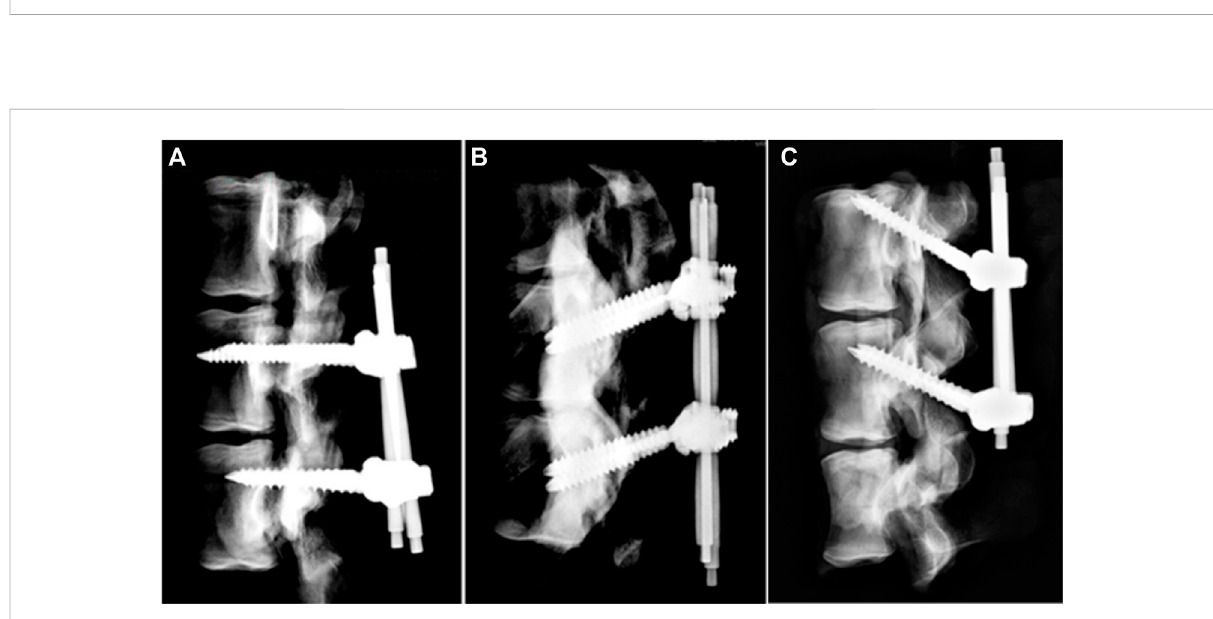
X-ray images of the FSU constructs after assembly of the screw and rod. (A) TT, (B) MT, and (C) CBT. Pedicle screws in each trajectory group of FSUswereimplantedaccordingtomethodsinsinglevertebrawithpairedsegmentalpediclescrews(diameter×lengthof6.0 mm×45